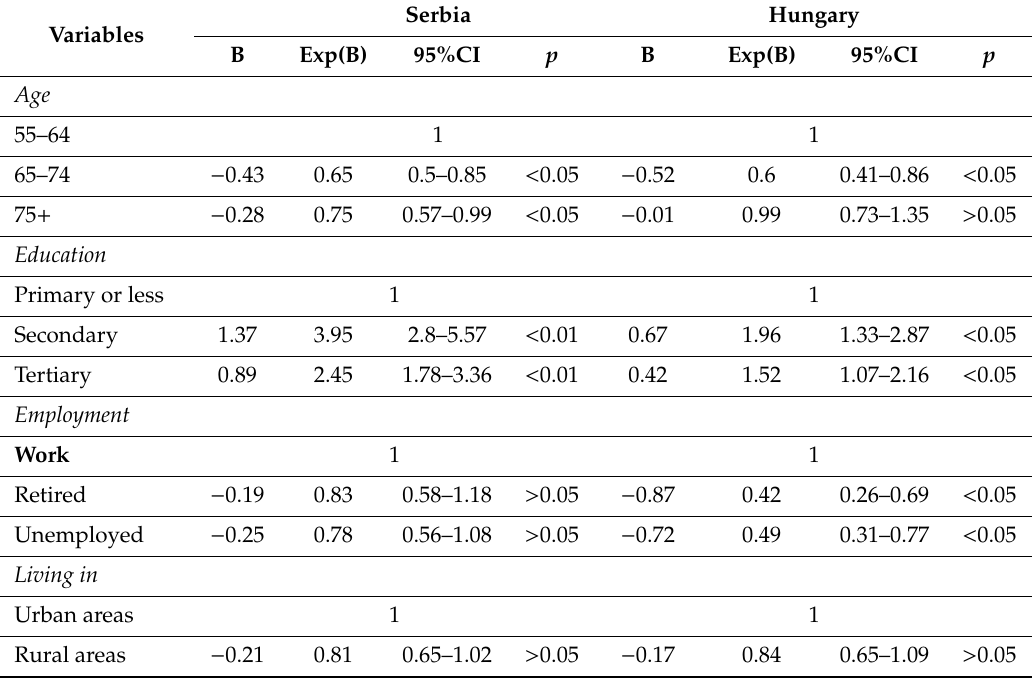
Table 2. Binary logistic regression for alcohol consumption among older women in Serbia and Hungary.